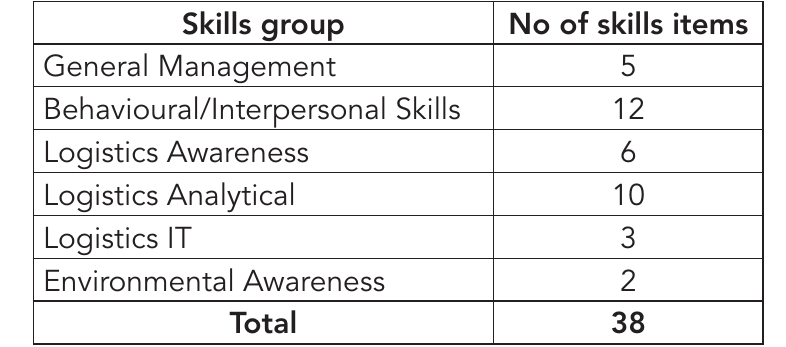
Table 1: Number of skills per skills